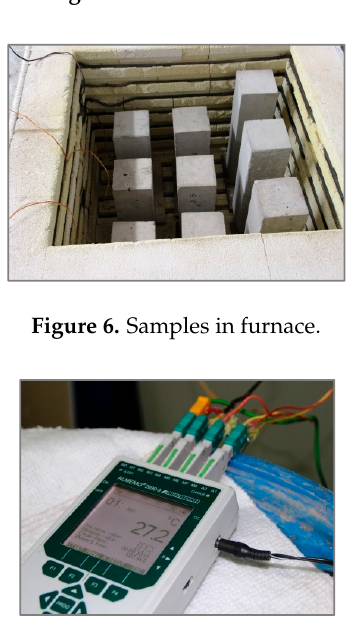
Figure 7. Measurement of the temperature in samples.